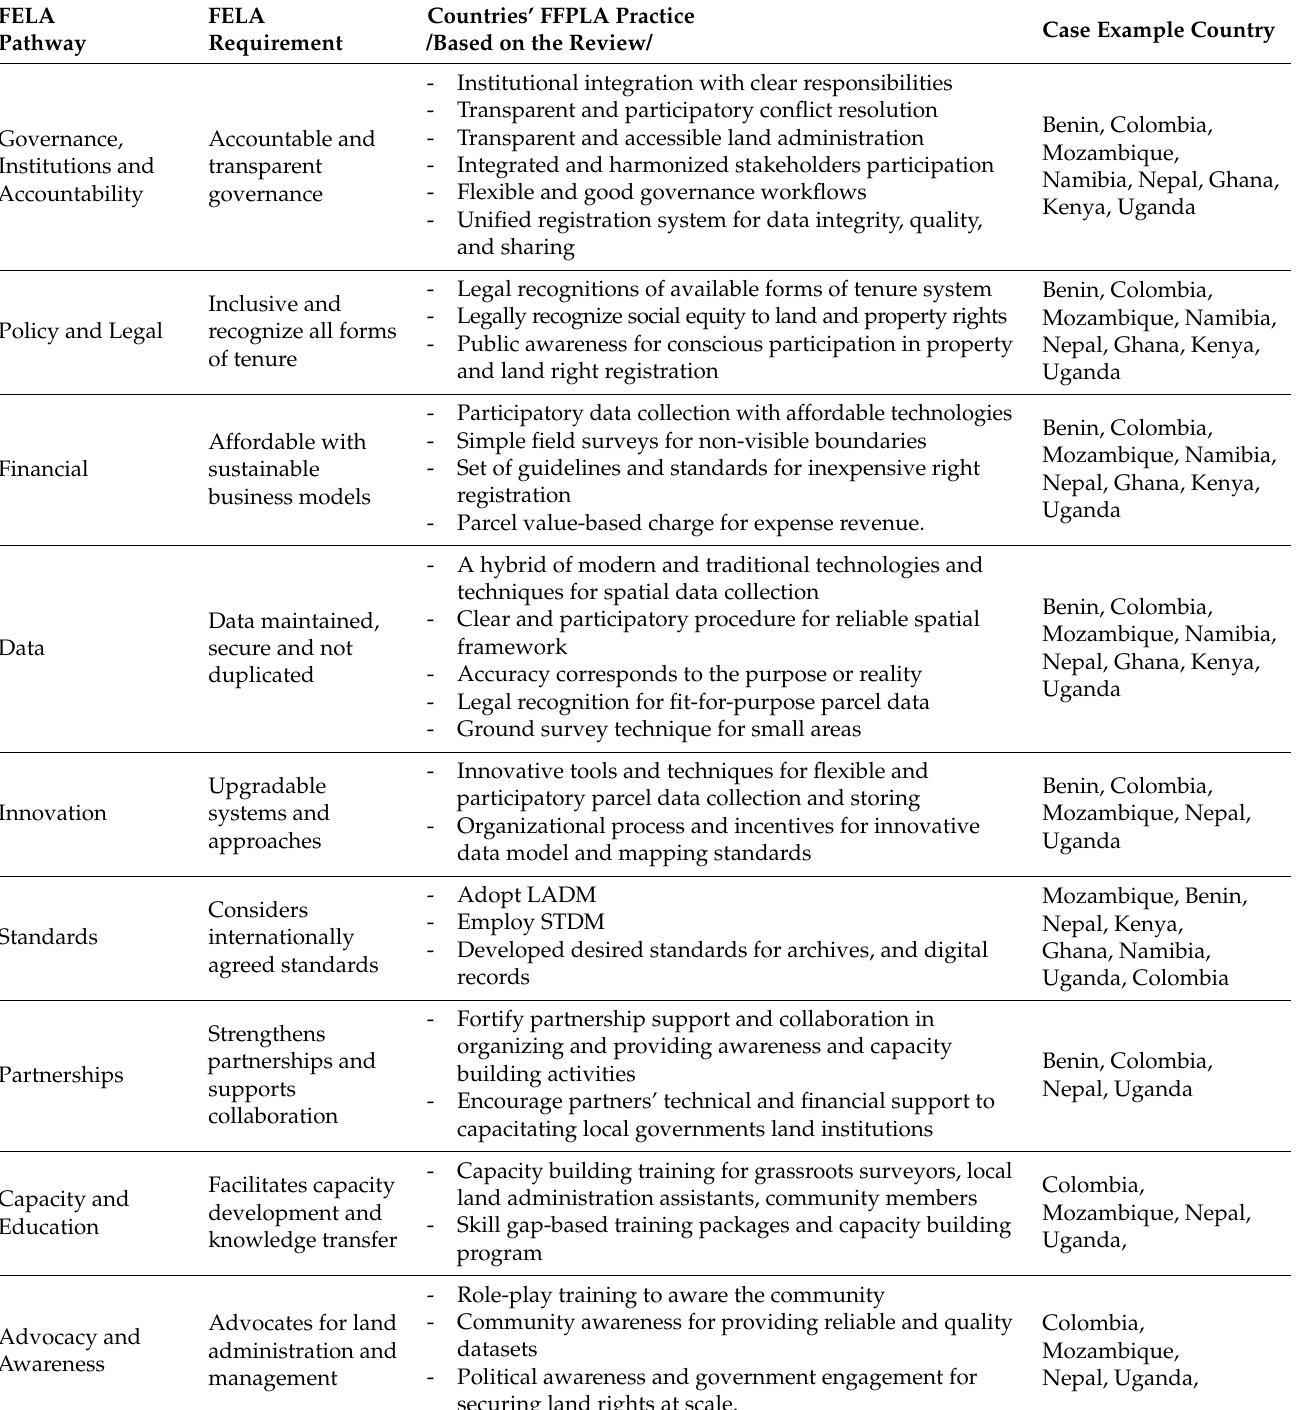
Table 5. Anticipated FFPLA implementation practices to address the FELA pathway